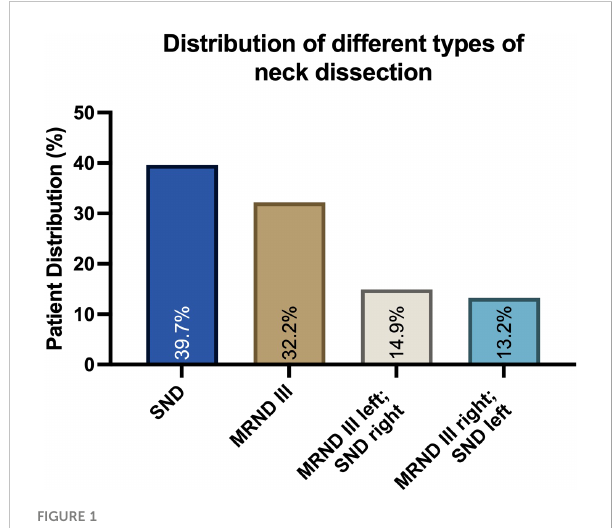
FIGURE 1 Distribution of different neck dissection types in a collective of 174 patients diagnosed with oral squamous cell carcinoma (OSCC). Data are represented as the percentage of the total, based on N=174 patients. Selective neck dissection (SND) and the anterolateral type were most frequent, followed by modi fi ed radical neck dissection (MRND) and a combination of both.